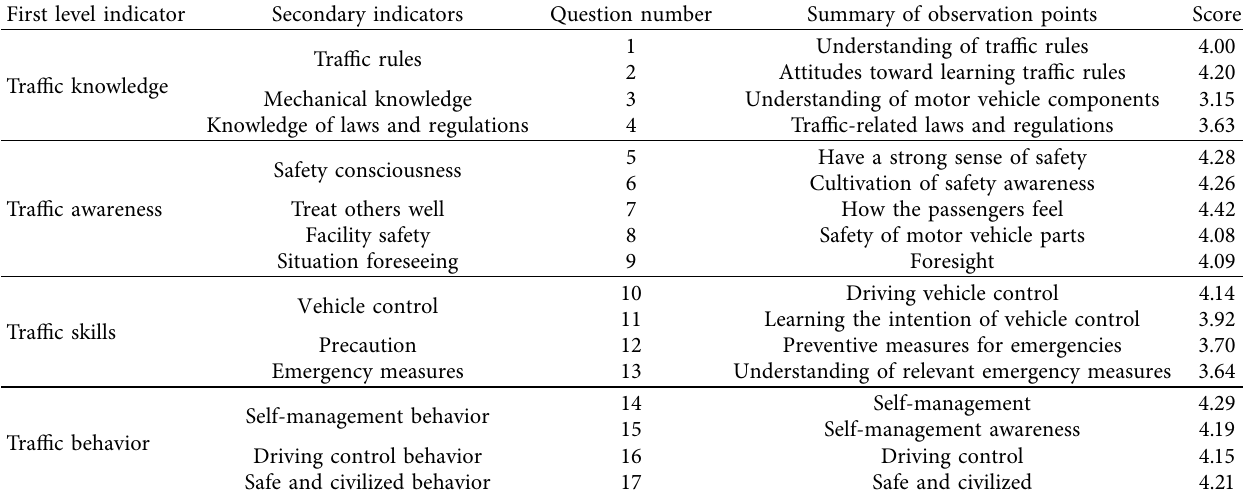
Table 9: Zhengzhou city motor vehicle driver traffic literacy evaluation factor